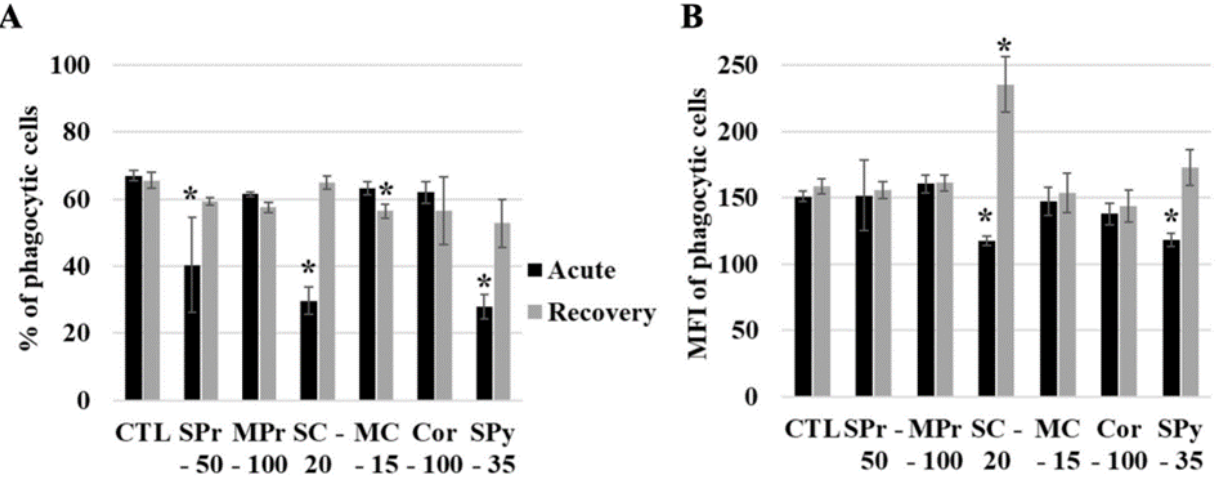
Figure 3. Phagocytic activity of cells exposed to SiO 2 particles. The acute exposure is (or is not) followed by a 72-h recovery period. CTL: control cells, SPr: small-particle precipitated silica 220 m 2 /g, MPr: medium-particle precipitated silica 55 m 2 /g, SC: colloidal silica 220 m 2 /g, MC: colloidal silica 140 m 2 /g, Cor: corundum, SPy: small-particle pyrogenic silica 200 m 2 /g. Black bars for acutely exposed cells, grey bars for recovery protocol. The data are expressed as mean ± standard deviation. ( A ) Proportion of phagocytic cells. ( B ) Phagocytic activity of the cells. Statistical significance in